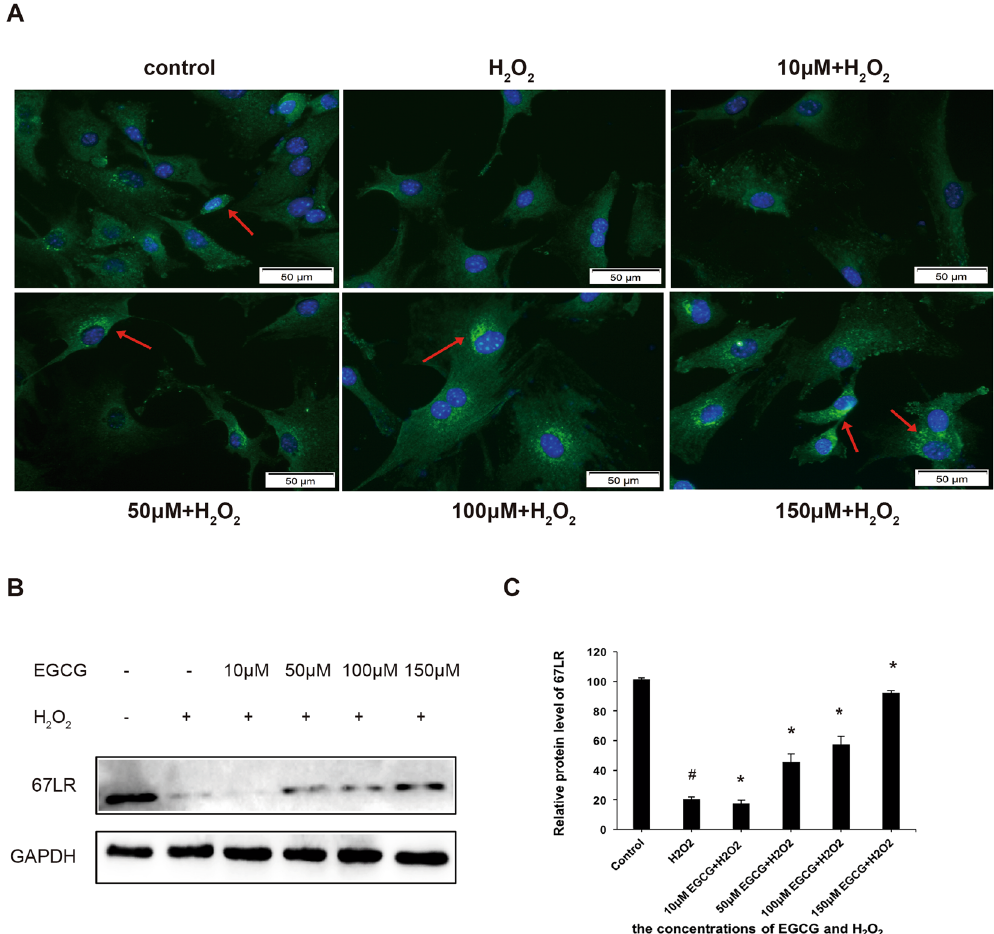
Figure 4. Effect of EGCG on H 2 O 2 -induced changes in 67LR. ( A ) Immunocytochemistry analysis was performed using anti-67LR antibody and Alexa Flouor-488 conjugated secondary antibody(green). The nuclei were stained with DAPI(blue). VSMCs were pretreated with 10, 50, 100, or 150 μ M EGCG for 2 h, followed by treatment with 200 μ M H 2 O 2 for 30 min. ( B ) Western blot showing the expression of 67LR after treatment with EGCG and H 2 O 2 . Results were expressed as Mean ± S.D. from 5 independent experiments. * P < 0.05 vs. H 2 O 2 treatment group, # p < 0.05 vs. control